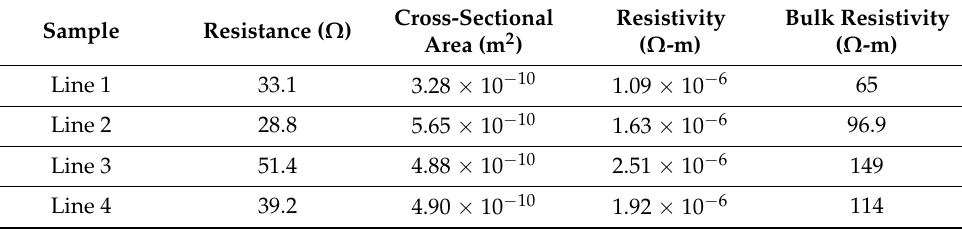
Figure 12. ( a ) CS Cu film, ( b ) CS Cu/G (0.019 wt% G) composite film, ( c ) friction coefficient of Cu and Cu/G composite films and wear tracks of the BoD ball on ( d ), ( f ) Cu film, and ( e , g ) Cu-G composite film. Presented with permission from [76]. Table 2. Resistivity measurements of 4 micro-CS-printed Cu//GNP lines. Presented with permission from